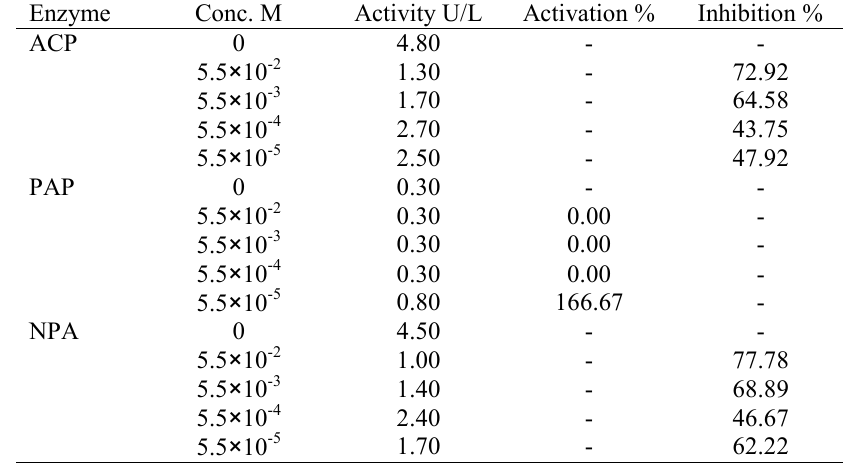
Table 2. The effect of different concentrations of compound A on the activity of ACP, PAP and NPA enzymes.